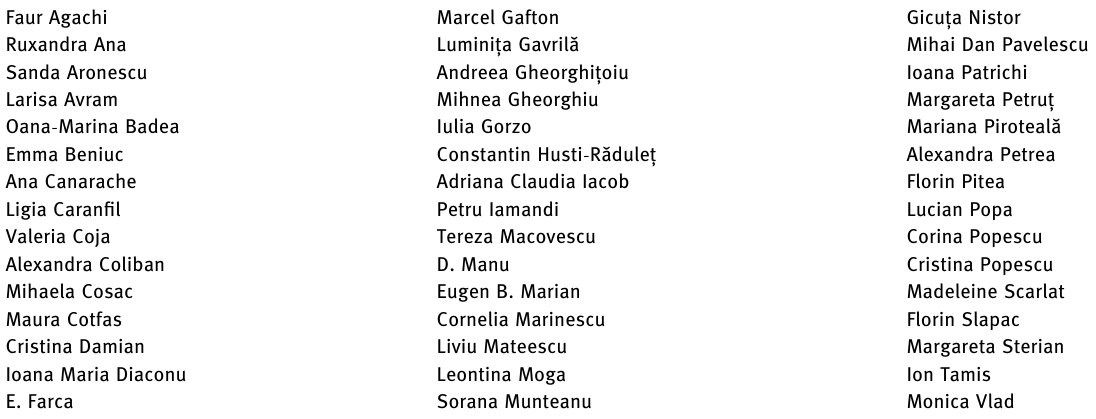
Table 2: List of Romanian translators